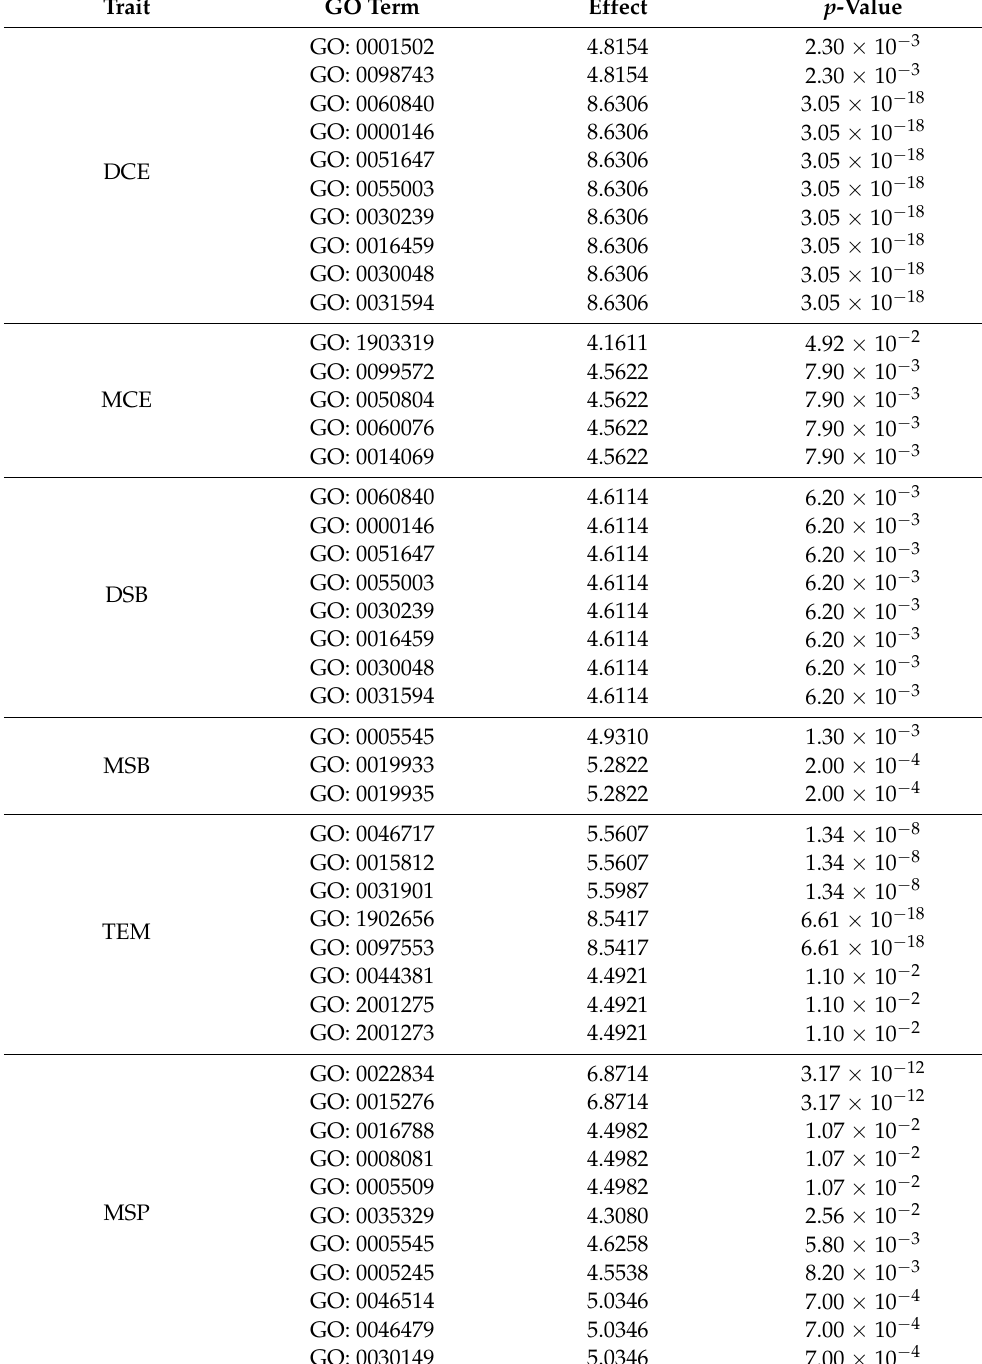
Table 2. Significant GO